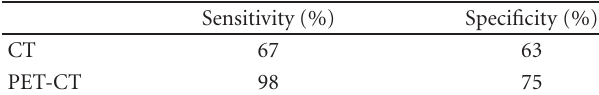
Table 3: Sensitivity and specificity of CT and PET-CT for detection of recurrent or metastatic CRC